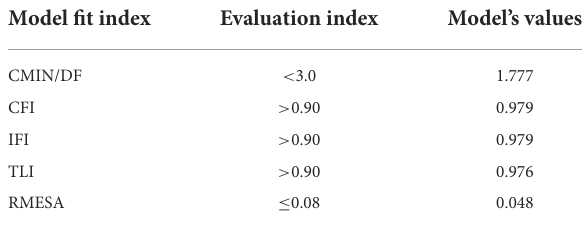
TABLE 7 Final fitting test.